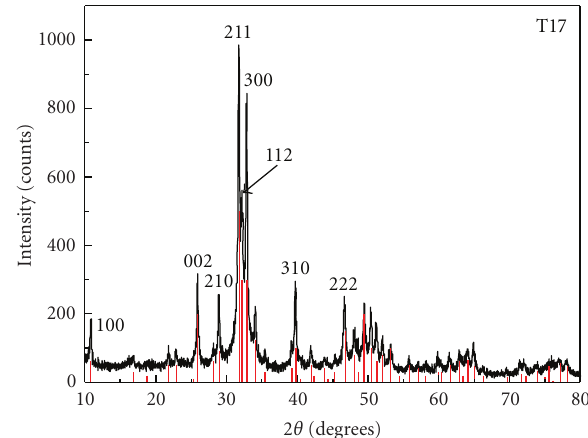
Figure 1: X-ray di ff raction pattern of the sample from the 17-year- old donor (T17). All the peaks match the HAp pattern number 9- 432 from the ICDS. A few minor peaks of unidentified phases are within detection limits of the